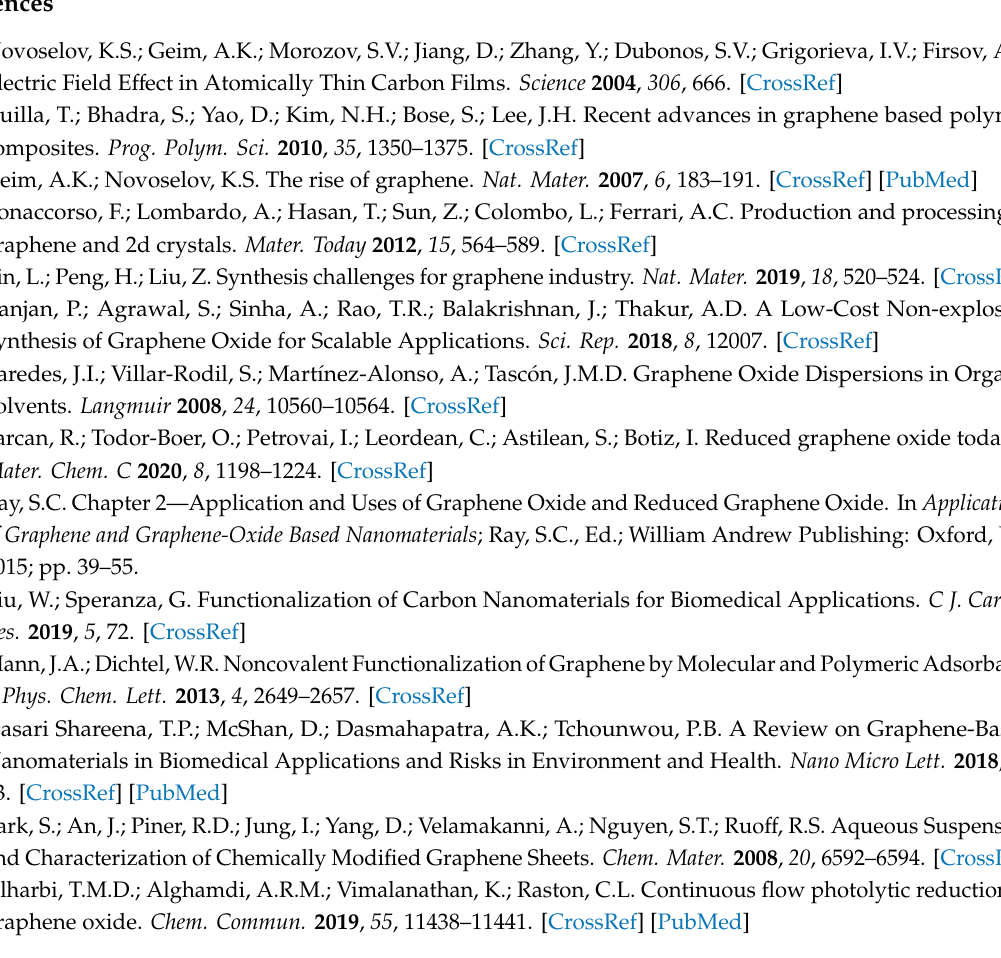
Figure S1: DSC first cycle after thermal history erases of PK30Gly-Gly29 and its respective composite with lrGO and hrGO. The first curves are not shown since they are carried out to remove the thermal history of the polymer and composites; Figure S2: TGA analysis of a) lrGO and b) hrGO; Figure S3: STEM micrograph of a) lrGO and b) hrGO; Figure S4: Raman spectrum of lrGO; Figure S5: Raman spectrum of hrGO; Figure S6: SEM picture of the PK30-Gly-Gly nanocomposite containing 7 wt% lrGO; Figure S7: SEM picture of the PK30-Gly-Gly nanocomposite containing 6 wt% of hrGO; Figure S8: Surface resistivity of the nanocomposite composed by PK30-Gly-Gly and lrGO at di ff erent temperatures and filler concentration. (A) 4 wt%. (B) 5 wt%. Sample thickness of 1.05